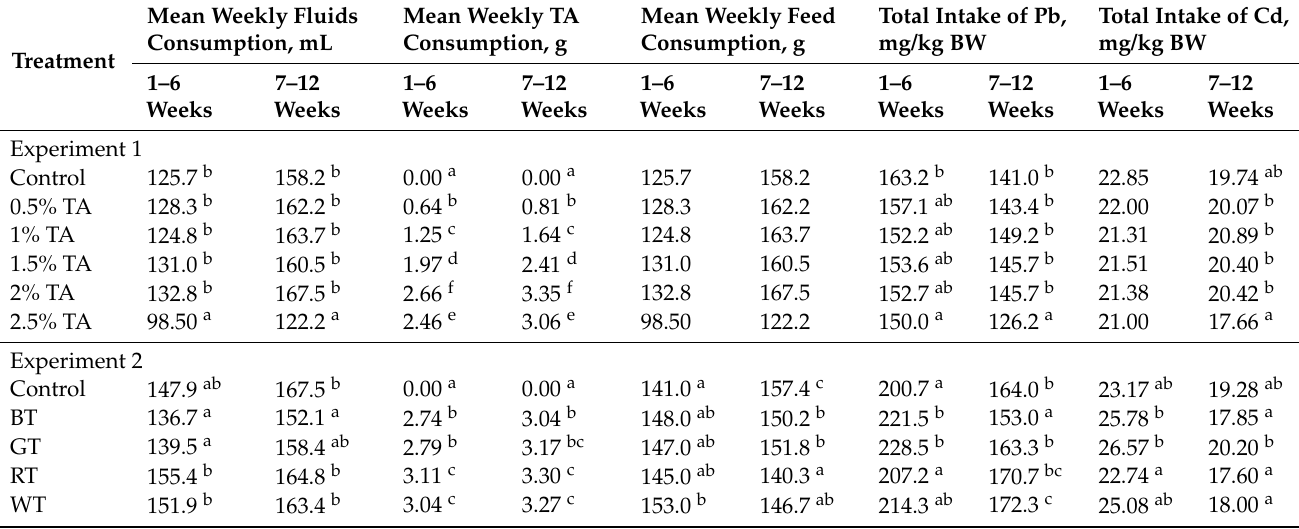
Table 2. Mean weekly feed, drinking fluids and TA consumption, total intake of Pb and Cd for 6 and 12 weeks of exposure.